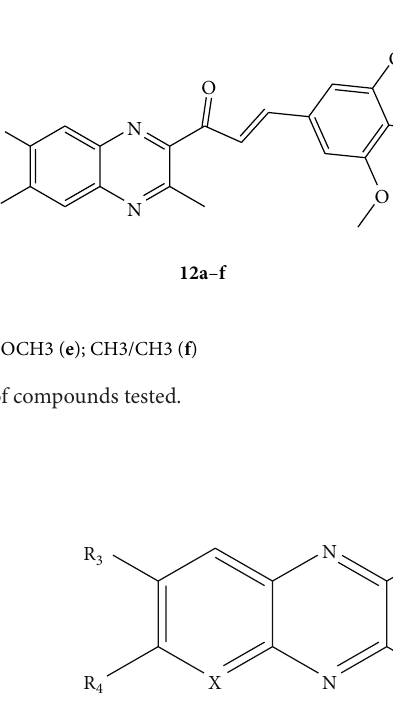
Figure 8: Chemical structures of compounds 15a – g .